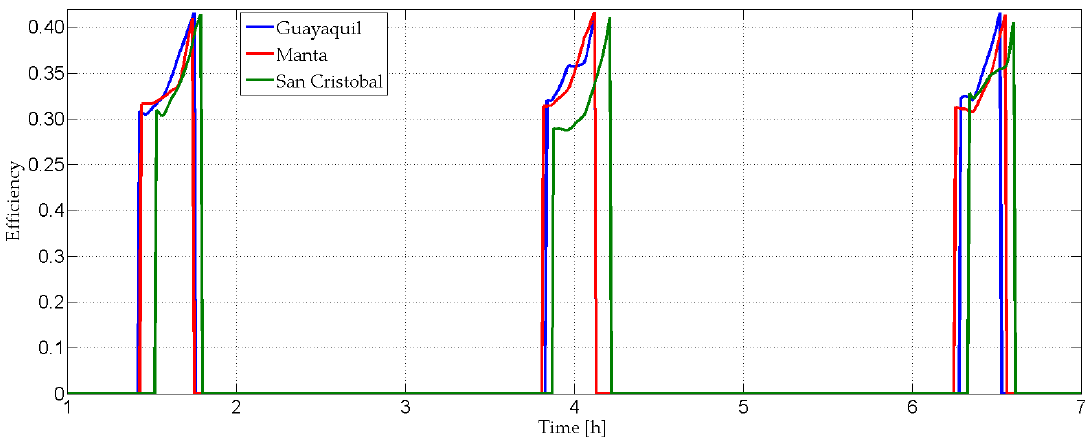
Figure 15. The overall efficiency of the solar power plant for the Guayaquil, Manta, and San Cristóbal during three days in February.